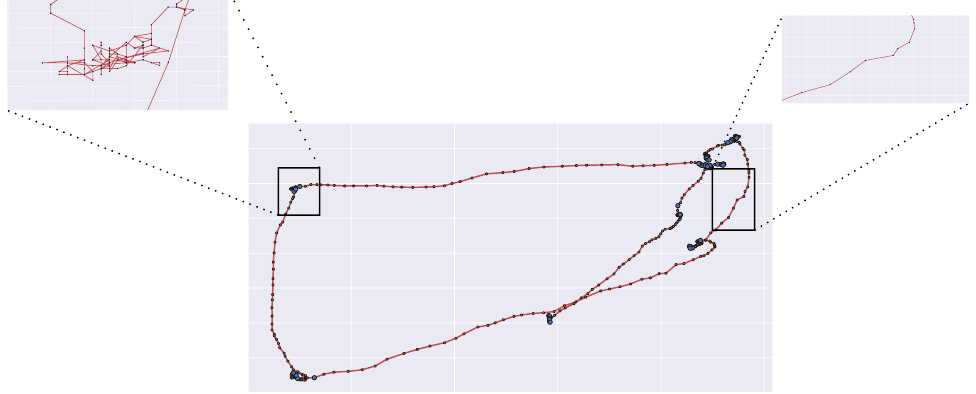
Figure 3. A zoom-in on fixations and saccades as recorded by high frequency